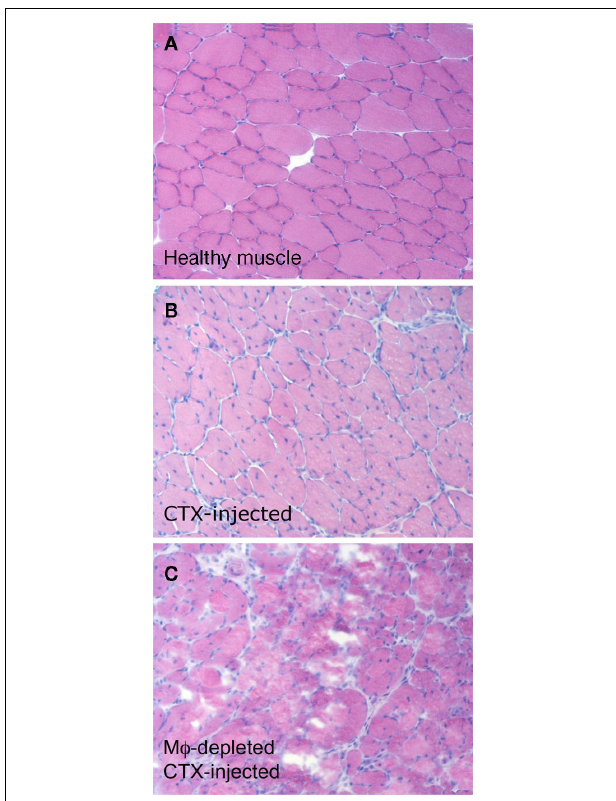
FIGURE 1 | Macrophages, recruited to the skeletal muscle after acute sterile injury, are necessary for effective tissue regeneration. Two months old C57BL/6 mice were treated i.m. with cardiotoxin (CTX). Mice were treated or not with clodronate-containing liposomes to deplete macrophages and sacrificed 15days after CTX injection. Tibialis anterior and quadriceps muscles were collected. (A) Healthy muscles of untreated control mice. (B) The muscle of macrophage-competent mice undergoes effective and almost complete regeneration in 15days: regenerating centronucleated fibers are evident throughout the section. (C) In the absence of macrophages, 15days after acute sterile injury regenerating fibers are hardly evident. Degenerated fibers and cell remnants